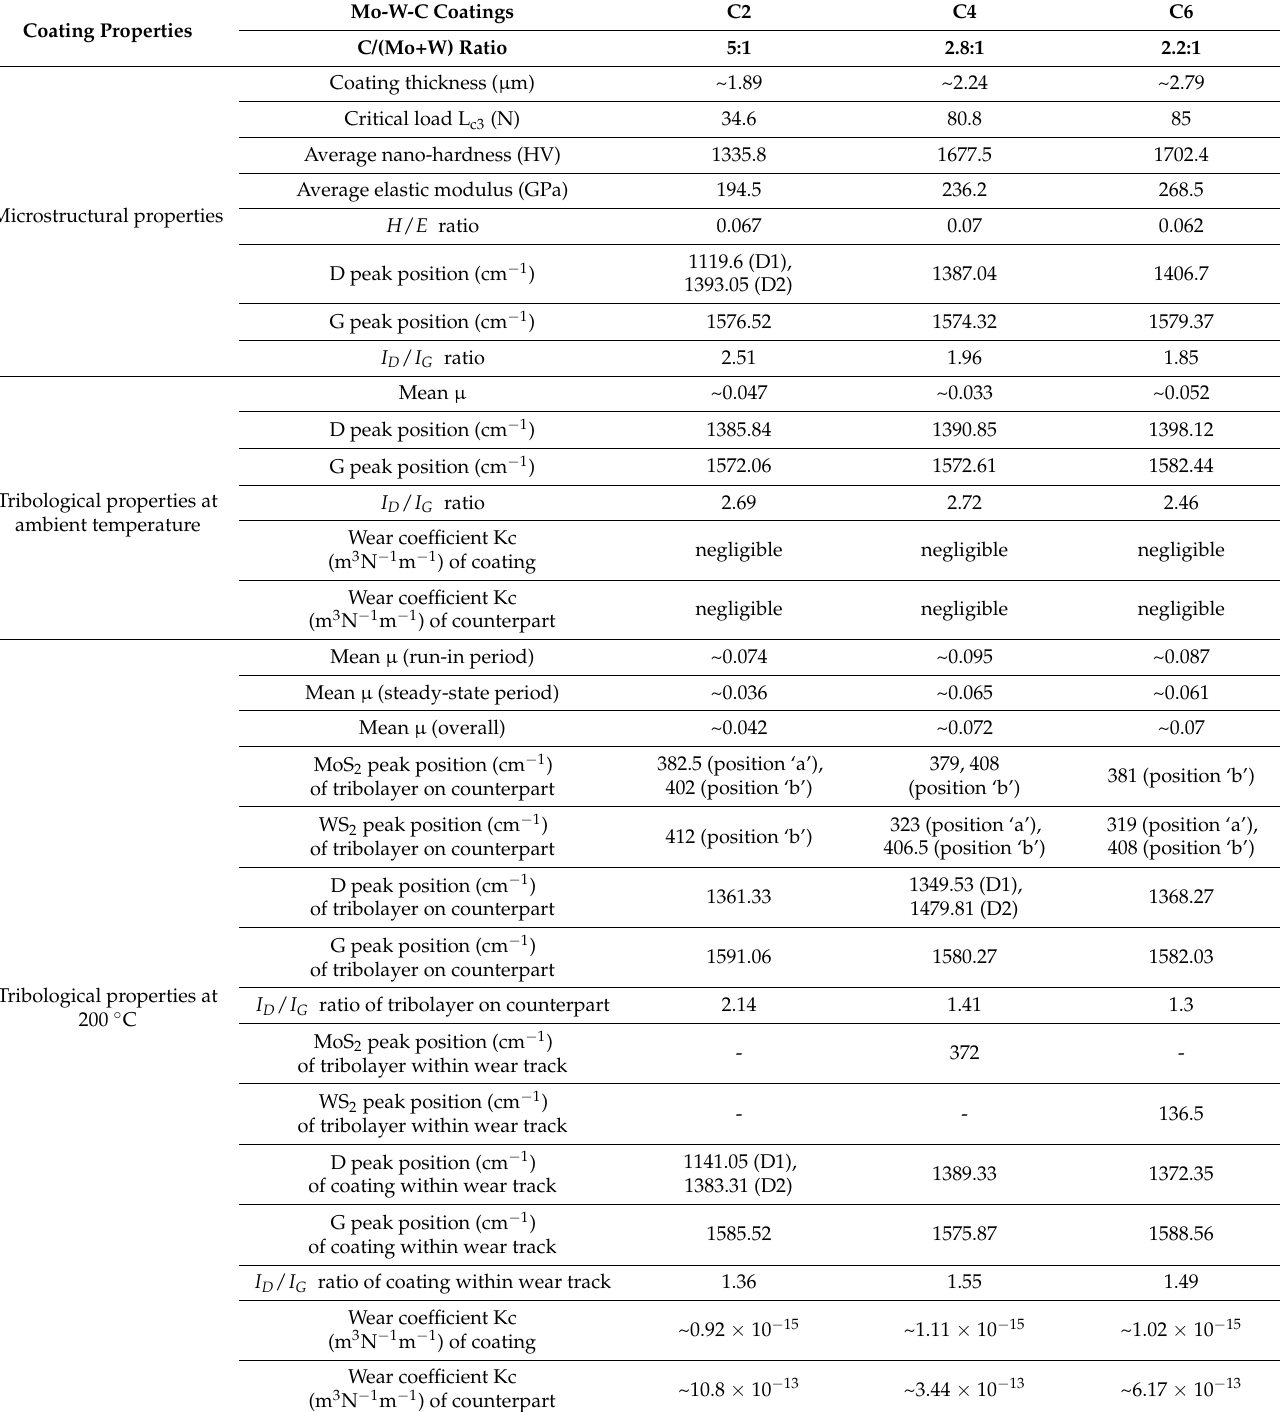
Table 3. Influence of C/(Mo+W) ratio on microstructural and tribological properties of Mo-W-C coatings. Coating